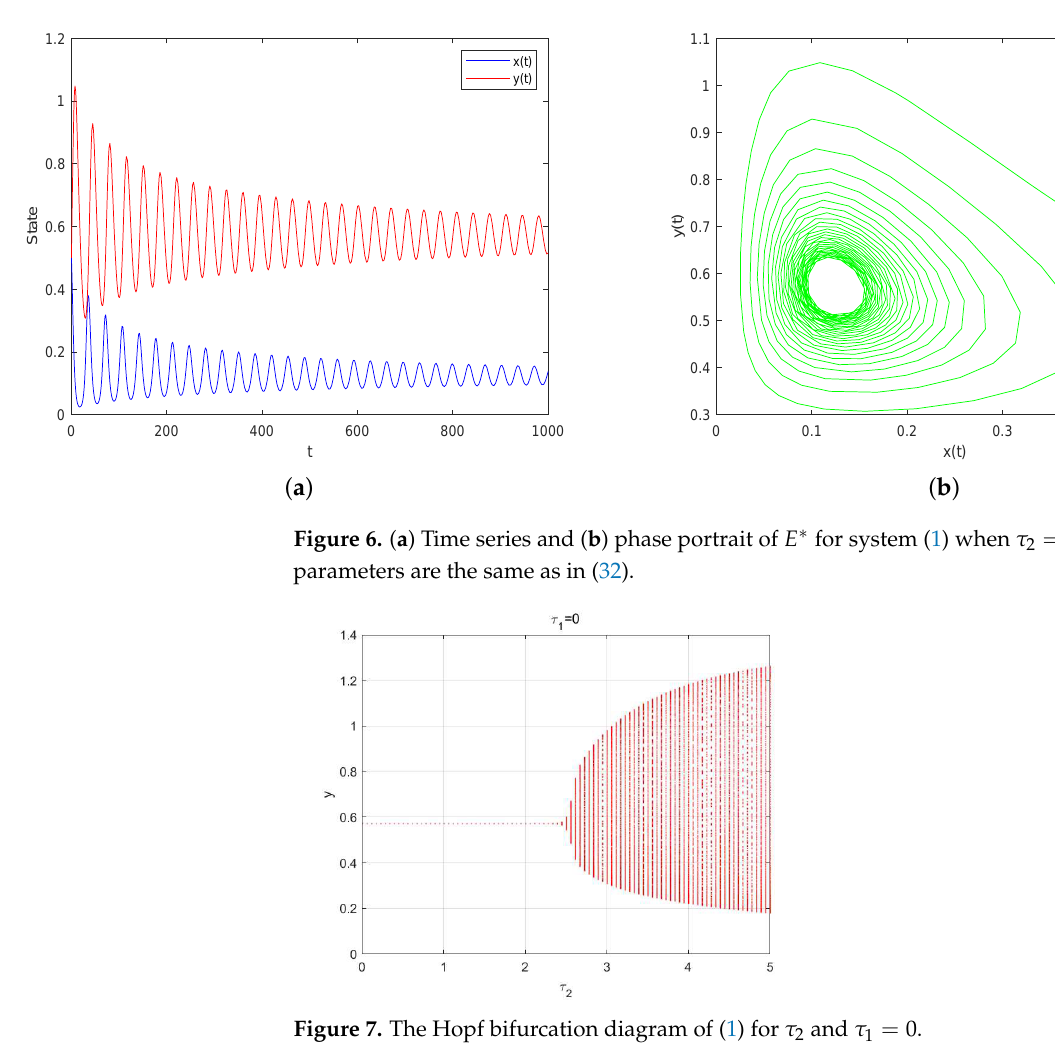
Figure 5. ( a ) Time series and ( b ) phase portrait of E ∗ for system (1) when τ 2 = 1.5 and τ 1 = 0. Other parameters are the same as in (32).